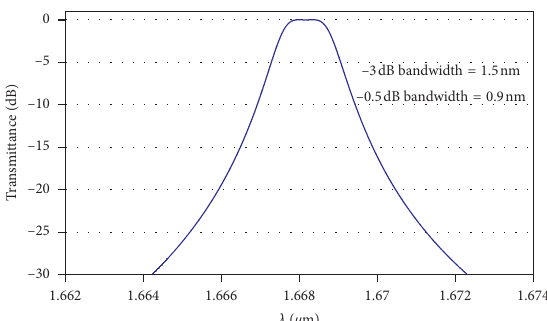
Figure 5: The channel shape profile for the LC refractive index ( n � 1.72).